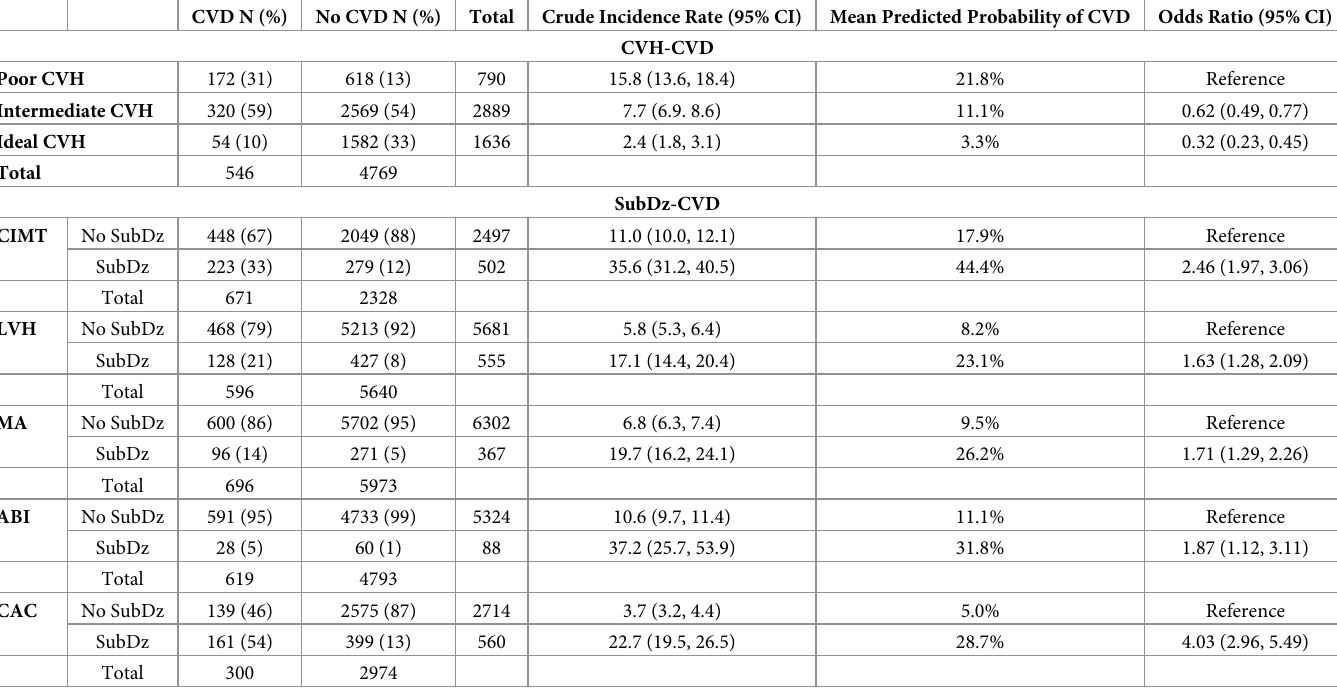
Note: Incidence rates are reported per 1000 person-years. Predicted probability and odds ratio is adjusted for age and sex. Data reflect the pooled sample including Offspring and Third Generation